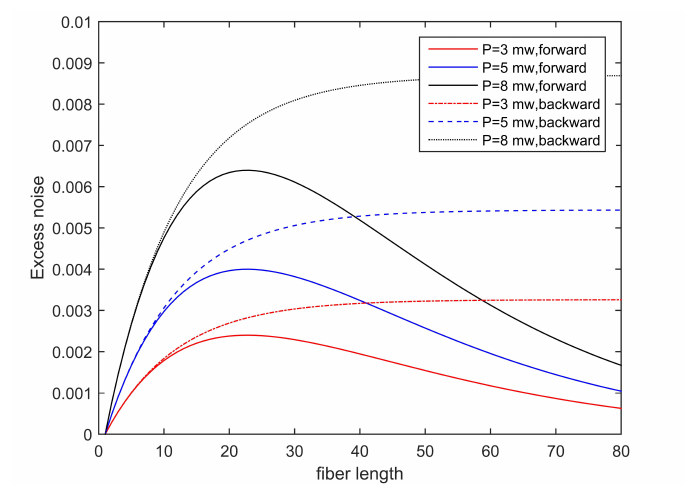
Figure 6. Total excess noise induced by Trojan horse attacks with various input powers in homodyne detection.